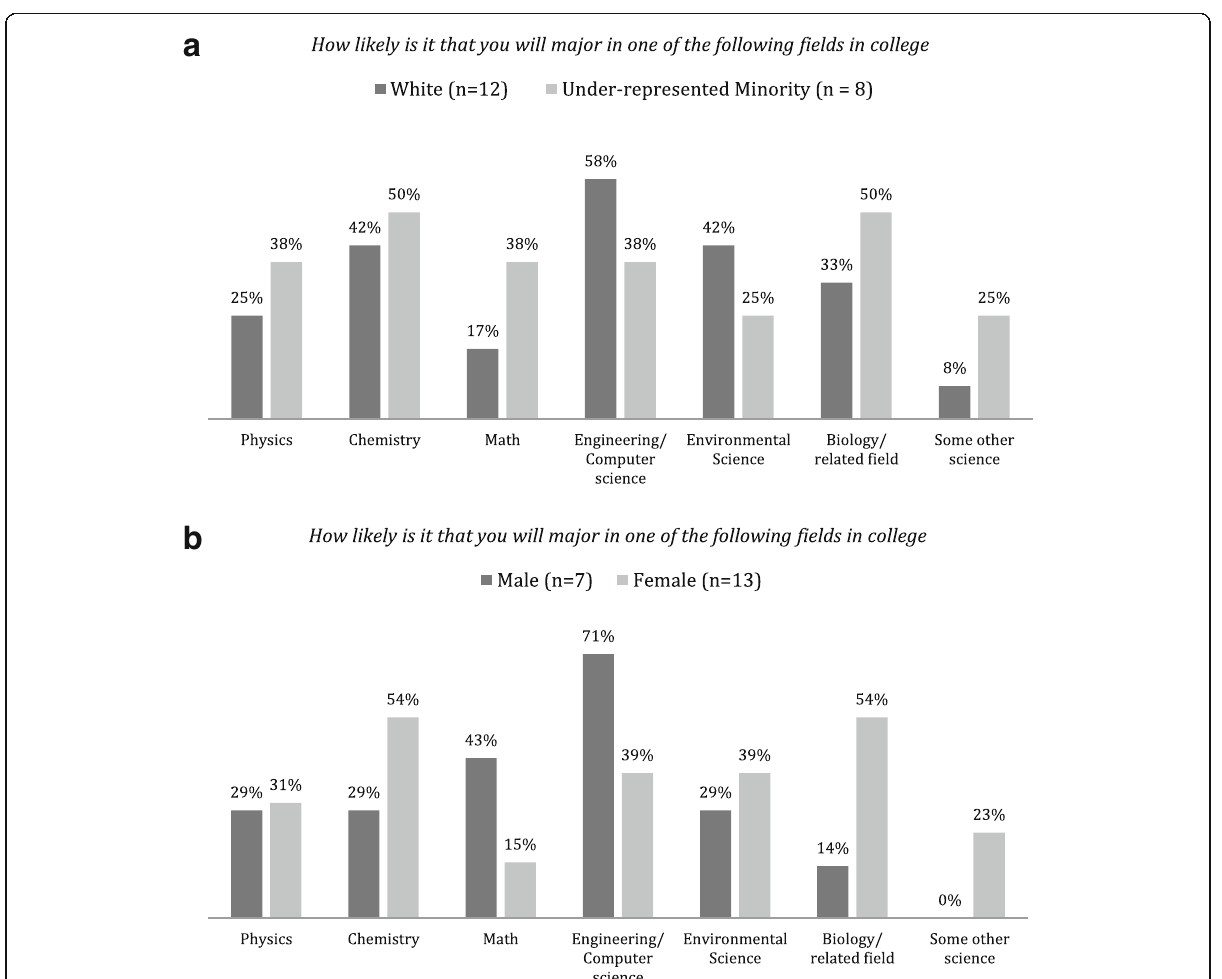
Fig. 4 a , b The result of a survey about the likelihood of majoring in STEM majors administered to participating 2015 – 2016 cohort 1 year after the SMART